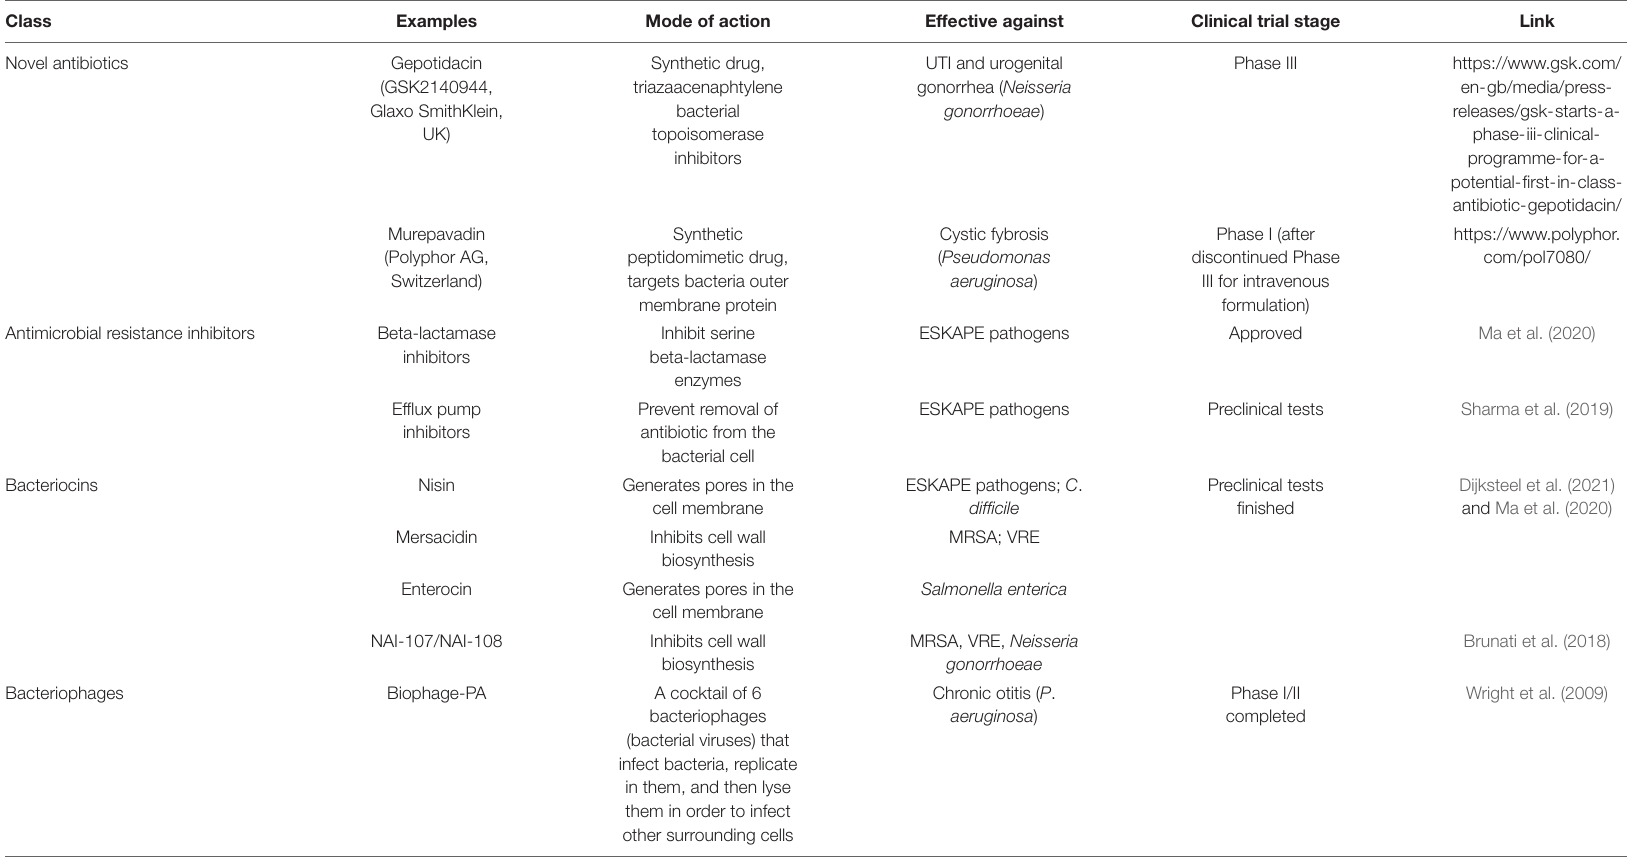
TABLE 2 | Overview of alternatives to current antibiotics discussed in this